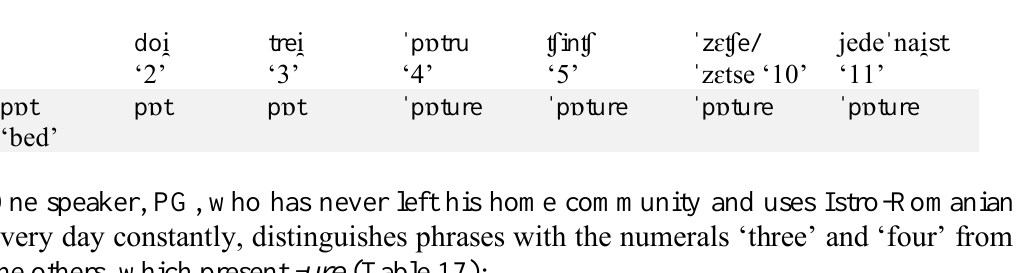
Table 16. Marking of the ‘four’ threshold by - ure in masculines